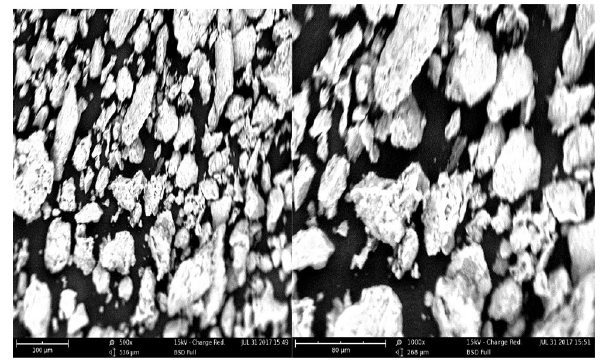
Fig. 6 SEM micrograph of 2-ABC at × 500 and × 1000 magnifications